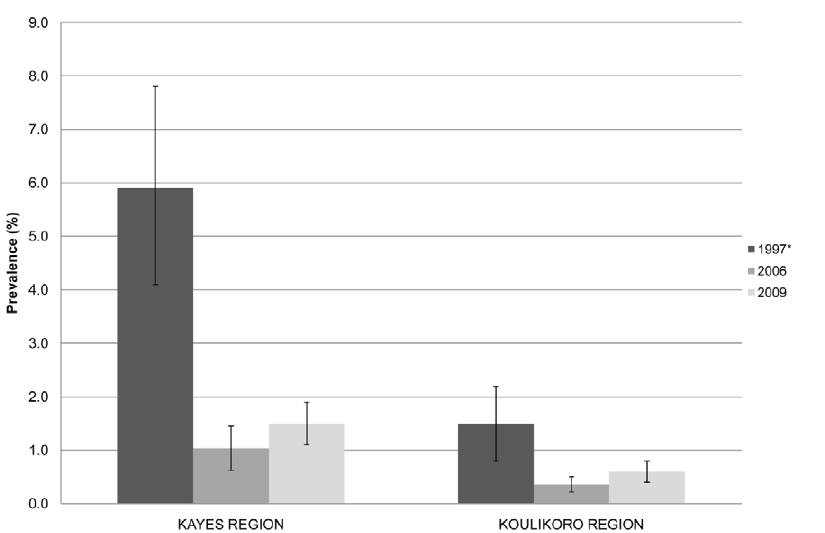
Figure 4. Prevalence of trachomatous inflammation intense (TI) among children under 10 years of age in Kayes and Koulikoro 1997*, 2006 and 2009. *regional estimate from Sche´mann et al 1998.